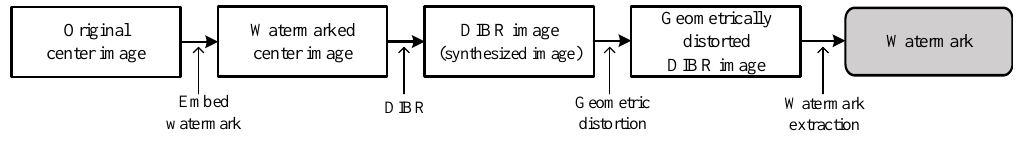
Figure 1. Watermark extraction scenario in a DIBR image with geometric attack. Extraction is possible only if the watermark survives both in the DIBR, which is a non-linear attack, and the geometric distortion, which is a linear